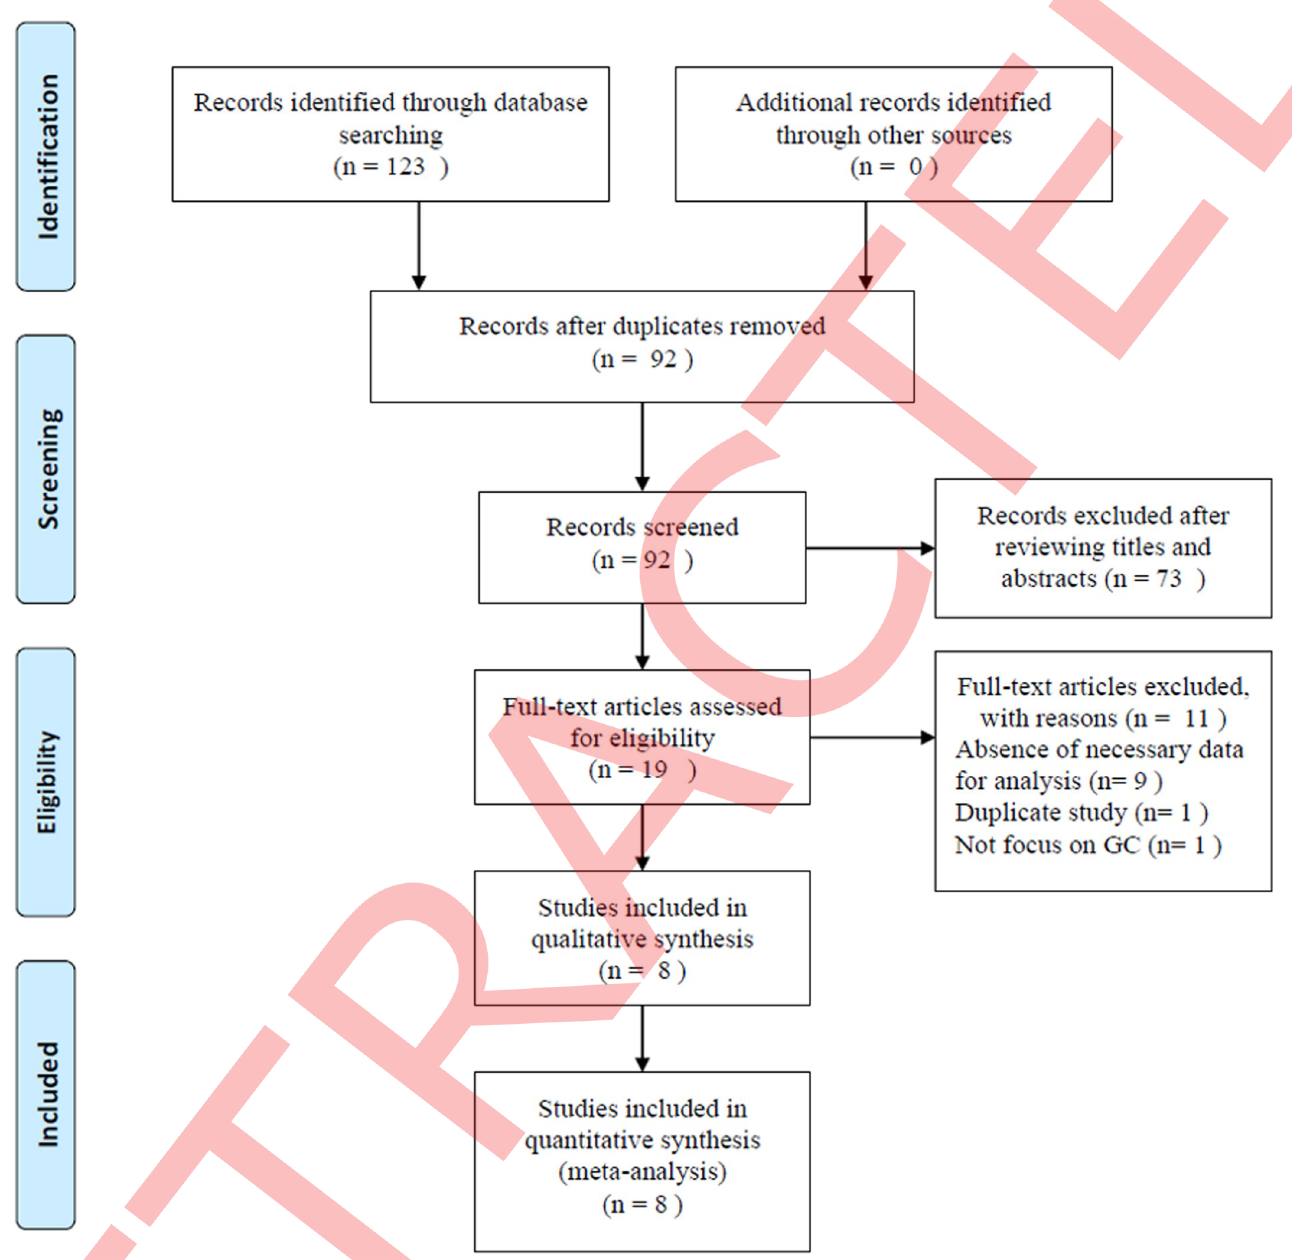
27]. The sample sizes ranged from 240 to 688; and the median value was 392.5. Six studies with 2,127 patients [22–27] reported the association between CAR and OS and 3 studies with 1473 patients [24, 28, 29] provided the data of CAR on CSS. Seven studies were of retrospective study design [22–28] and 1 study was a prospective study [29]. The cut-off values of CAR ran- ged from 0.0232 to 0.5897 in included studies. The NOS scores of included studies ranged from 6 to 9, with a median value of 7.5, indicating that all included studies were of high- quality.